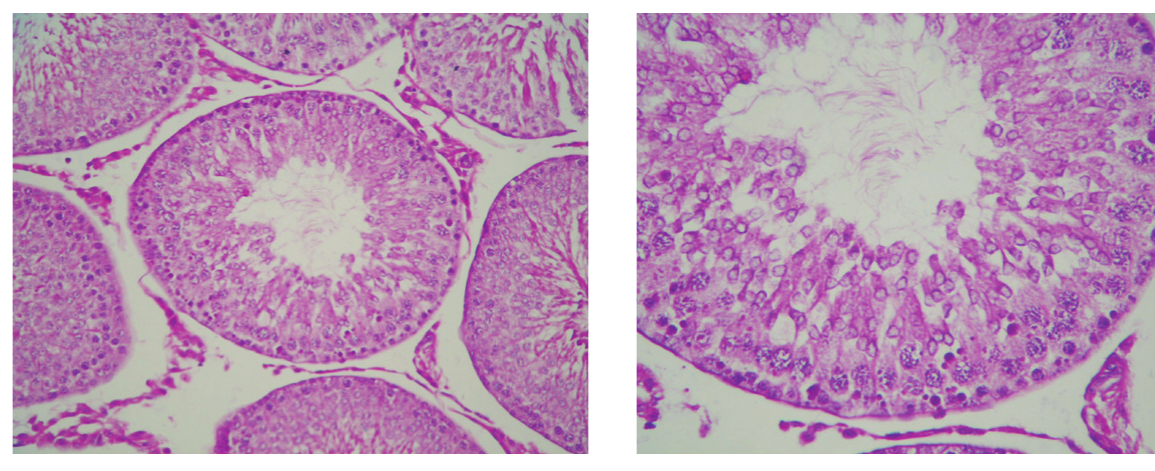
Figure 2a - Spermatogenesis with a Johnsen score of 7.8 in paroxetine group (H-E, x100).